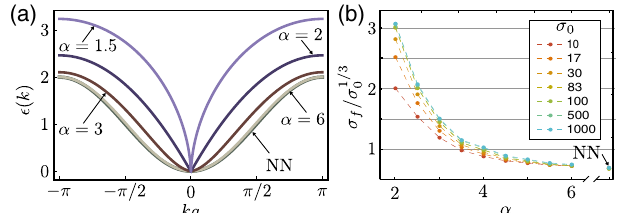
FIG. 4. (a) Dispersion relation ϵ α ð k Þ for long-range flip-flop interactions (see text) for different exponents α and nearest- neighbor (NN) interactions. (b) Rescaled final width σ different exponents α and for different initial conditions σ 0 . The data points on the very right correspond to nearest-neighbor